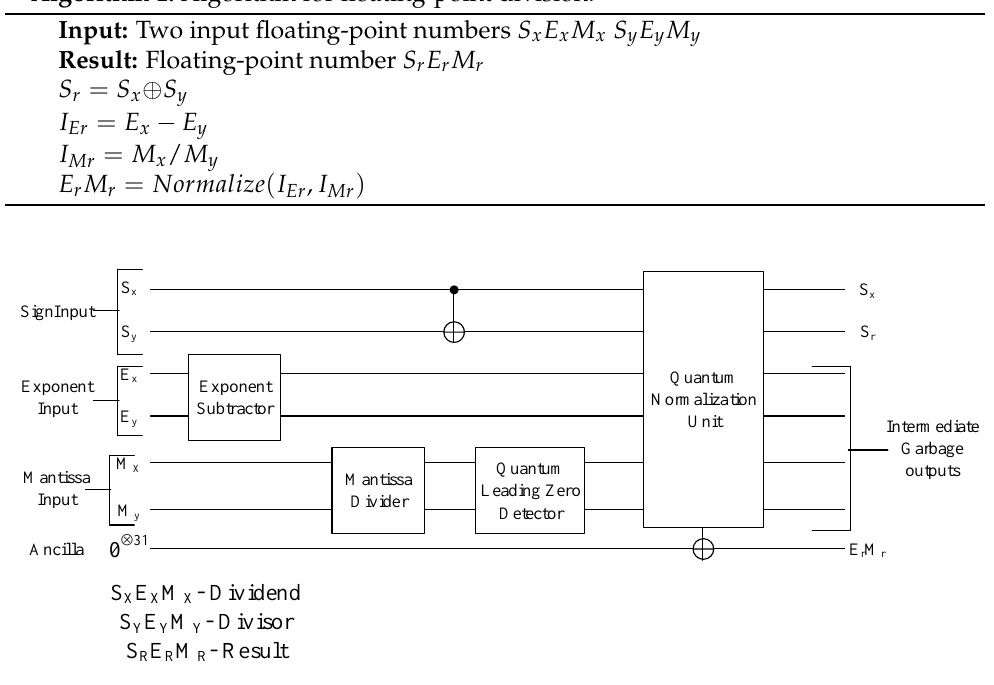
Figure 1. High level overview of Quantum floating-point division circuit.